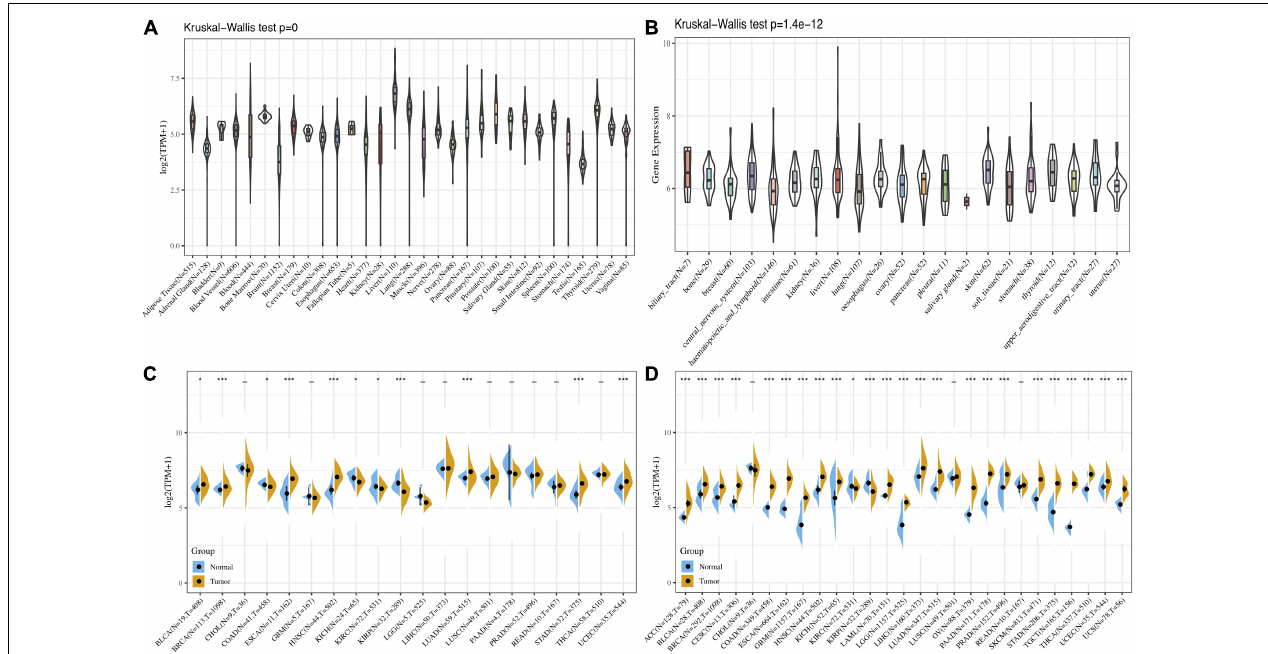
FIGURE 1 | The expression levels of FURIN across cancers. (A) Data of the GTEx database showed the expression levels of FURIN in diverse normal tissues. (B) Data of the CCLE database showed the expression levels of FURIN in diverse cancer cells. (C) Data of the TCGA database showed expression of FURIN in diverse cancers and normal tissues. (D) Data of the TCGA database and the GTEx database showed FURIN expression in diverse kinds of tumors (* p < 0.05, ** p < 0.01, *** p <